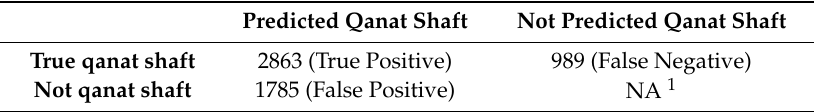
Table 2. Confusion matrix obtained from five-fold cross-validation.